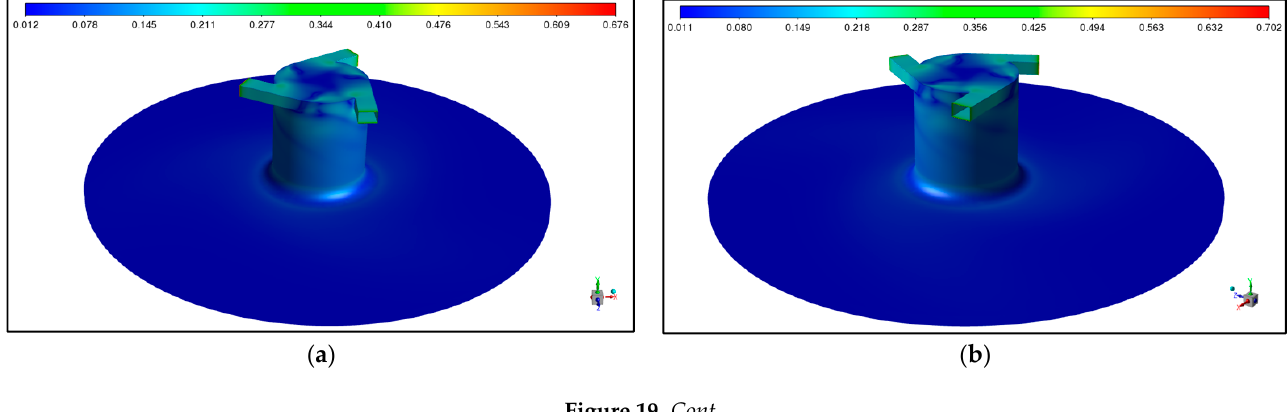
2 . Figure 18. Power costs and losses distribution for ( a ) air ; ( b ) He ; and ( c ) CO 2 .